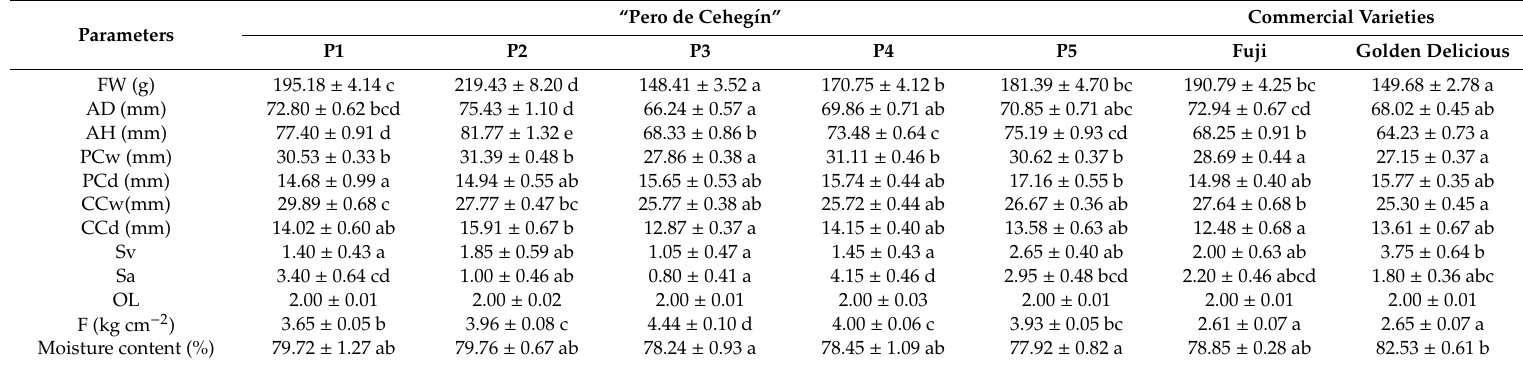
Table 4. Mean values of the morphological parameters measured in five clones of “Pero de Ceheg í n” and two varieties of reference (“Fuji” and “Golden Delicious”) harvested in